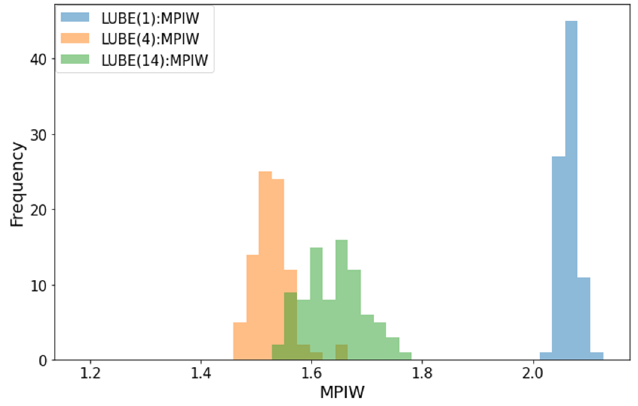
Figure 10. Histograms of 2-week average MPIW for LUBE(1), (4), and (14). Table 4. Statistics of 2-week average PICP.